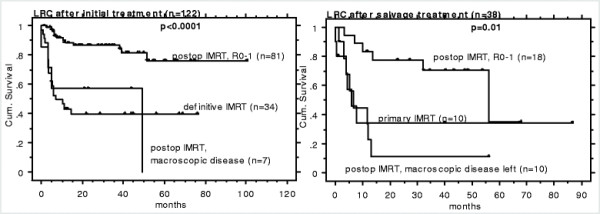
 LRC following IMRT in 122 patients with initial OCC diagnosis (left) and in 38 patients with salvage treatment of OCC recurrence following surgery alone (right).